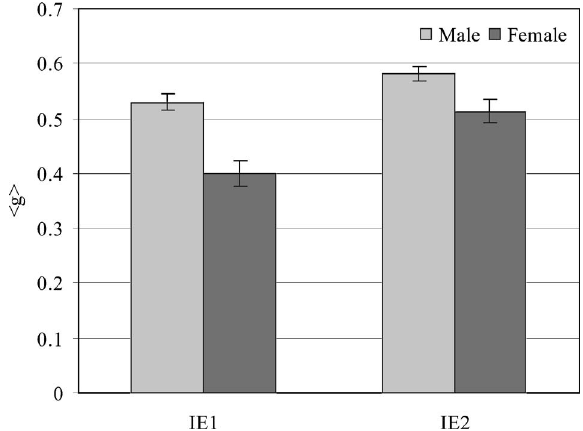
FIG. 1. Gender gap. Effect of instructional approach on gender gap in student performance on FMCE for CU students averaged across three semesters for IE1 (cid:1) partially interactive (cid:2) and three se- mesters IE2 (cid:1) fully interactive (cid:2) . Error bars represent standard errors of the mean. There is no statistically significant shift in gap of performance by gender for either IE1 or IE2.